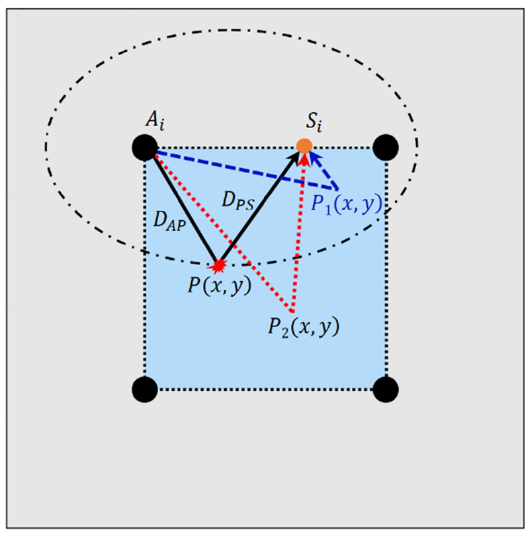
Figure 5. Schematic diagram of the delay-and-sum imaging method.